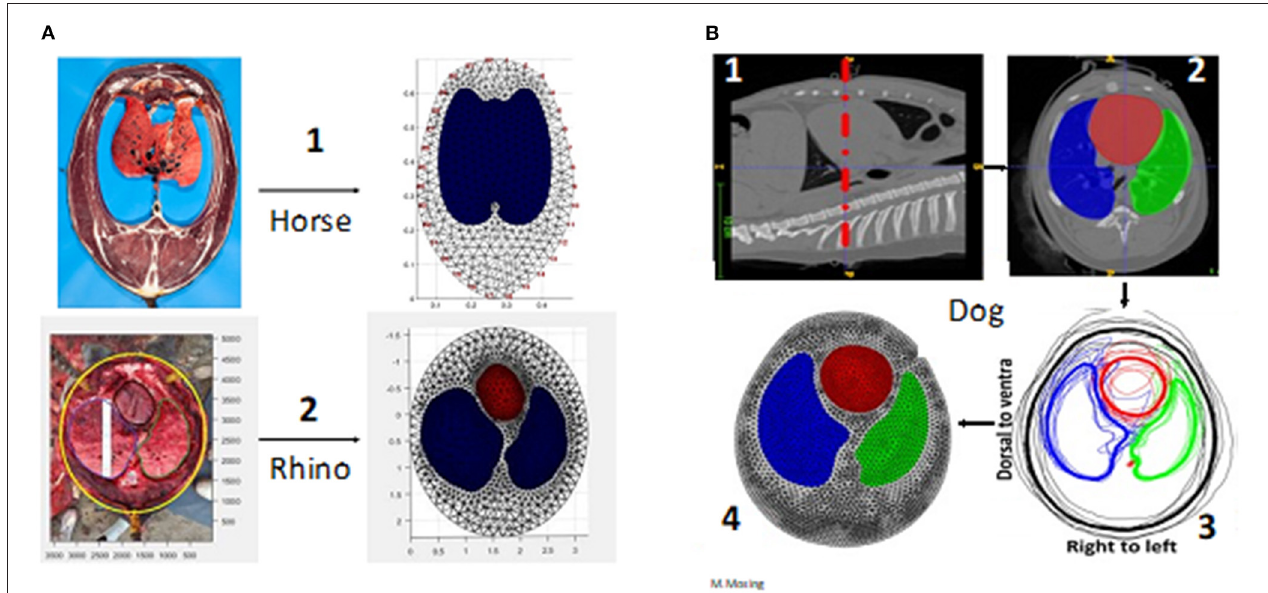
FIGURE 4 | Creation of finite element models. (A) Via anatomical model. A1 is a frozen slice of a horse specimen, A2a fresh dissection of a rhino thorax in situ . (B) Via computed tomography (CT) imaging in the dog (beagle). B1. CT image of the correct anatomical position (the belt position highlighted with red dashed line) B2. Segmentation of the regions of interest (the heart and lungs red = heart; green = left lung; blue = right lung) B3. Averaging from multiple animals (Thick black line = averaged outer contour) B4. The completed finite element